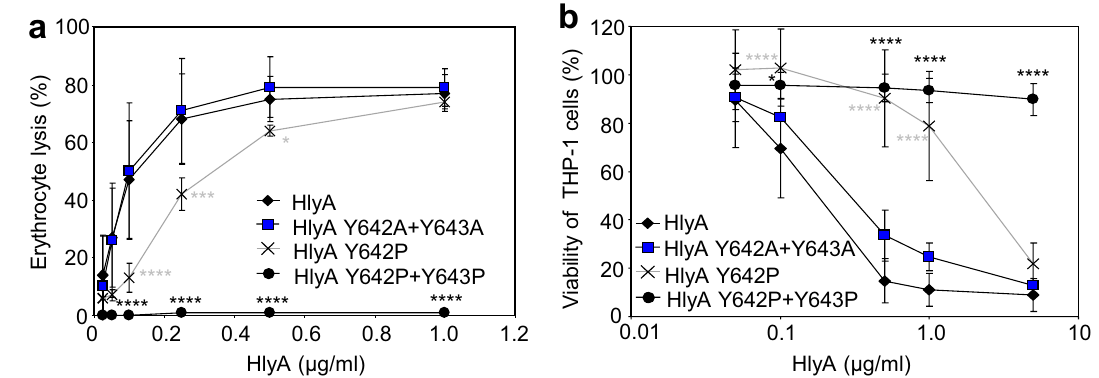
Figure 5. A tyrosine residue pair plays a role in cytotoxic activity of HlyA. Hemolytic activity of HlyA variants ( a ) was analyzed as detailed in Fig. 4. Each point represents the mean ± SD of three independent determinations performed in duplicate with two different toxin preparations. ( b ) Cell viability was analyzed on THP-1 cells as detailed in Fig. 4. Each point represents the mean ± SD of three independent determinations performed in triplicate with two different toxin preparations. Significant differences are indicated by asterisks (* p < 0.05; *** p < 0.001; **** p < 0.0001).